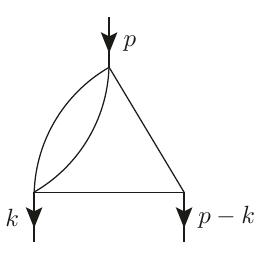
Figure 3 . Three-mass triangle integral with massless propagators appearing in the calculation of the wavefunction at two loops. This type of integrals contribute to the amplitude only starting at four loops, due to the symmetry of the problem, as discussed in the main text. The bubble integral on one of the two edges of the triangles clari(cid:12)es the origin of the propagator which is raised to power (cid:15) in eq.